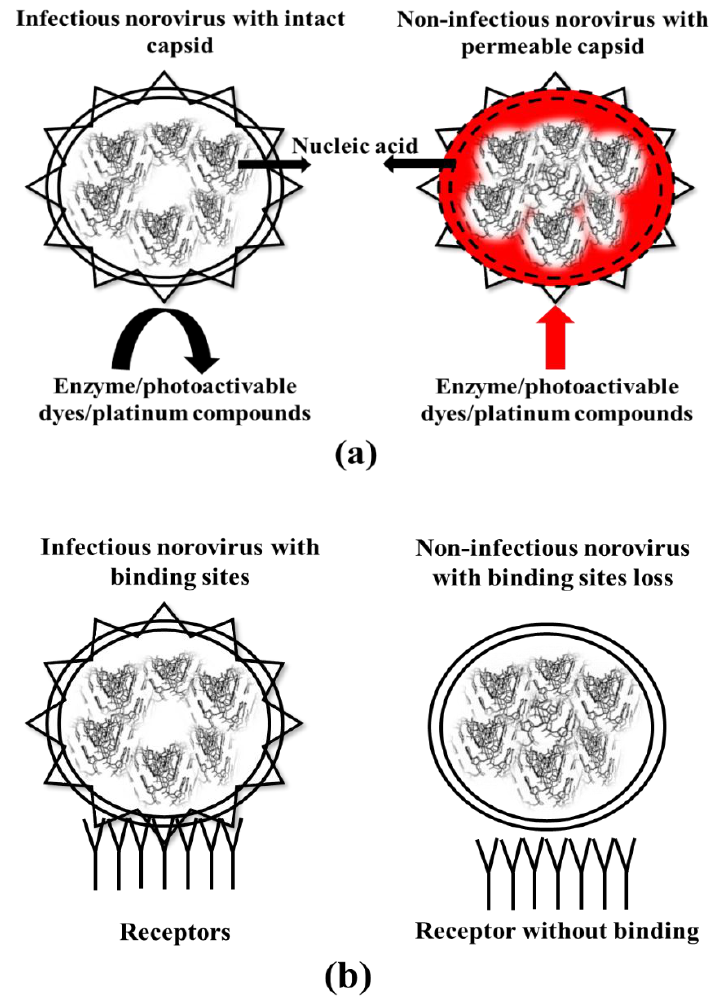
Figure 2. Mechanism of infectious RT-qPCR ( a ) and binding assays ( b ) for the differentiation between infectious and non-infectious norovirus. In the assay, enzymes or compounds enter the permeable capsid of non-infectious viruses and interact with the nucleic acid. The viral nucleic acid is then inactivated or degraded and hence cannot be detected in the subsequent qPCR assays. In the receptor binding assay, the binding site of the virus is lost on non-viable viruses allowing specific binding or capture of infectious viruses only.